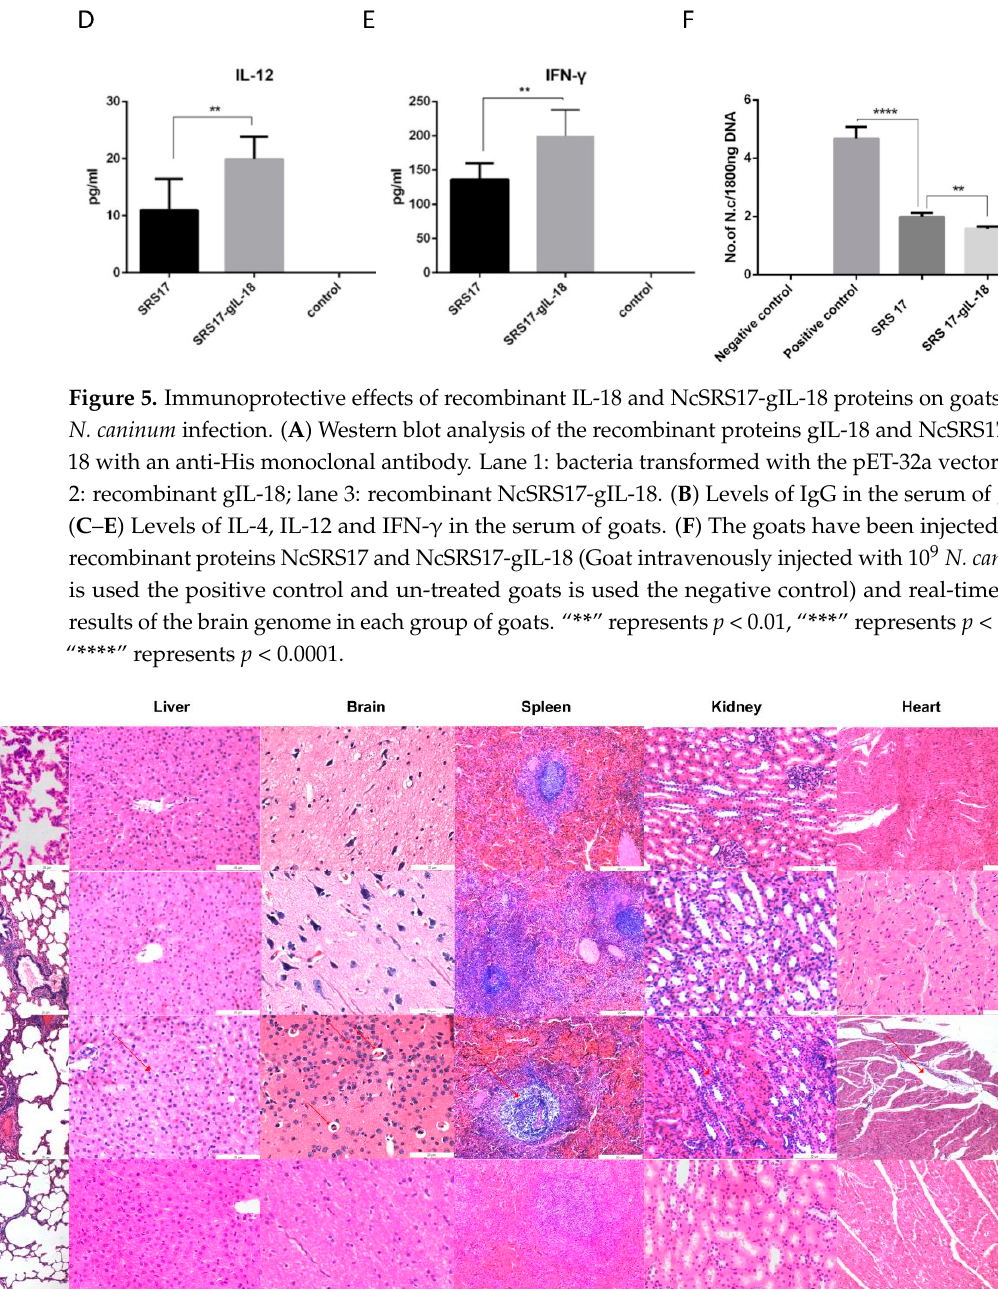
Figure 6. Histopathological changes in the heart, liver, spleen, lungs, kidneys and brain tissues of goats. The second immunization was carried out two weeks after first immunization in goats, and the serum was collected ten days after second immunization. Histopathological analysis of the heart, liver, spleen, lung, kidney and brain tissues of goats in the positive control, NcSRS17-immunized and NcSRS17-gIL-18-immunized groups was conducted with HE staining, and observations were conducted at a magnification of 200 ×